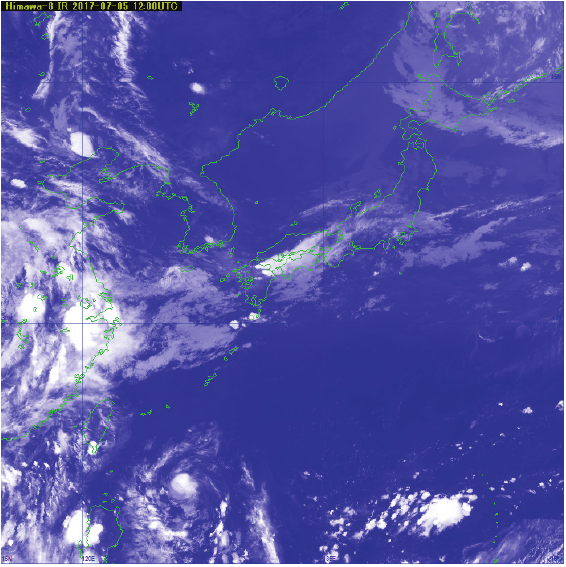
Figure 3. JMA weather satellite image (12:00 July 5,